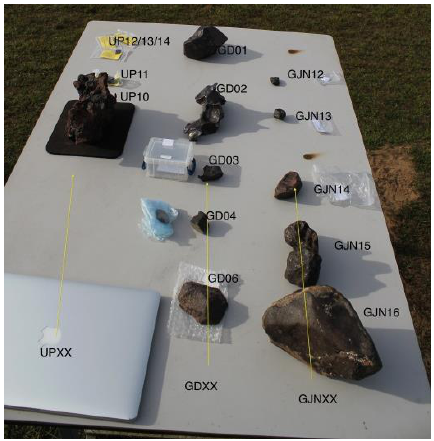
Figure 8. Collection of meteorites used in the detection experiment on grassland.